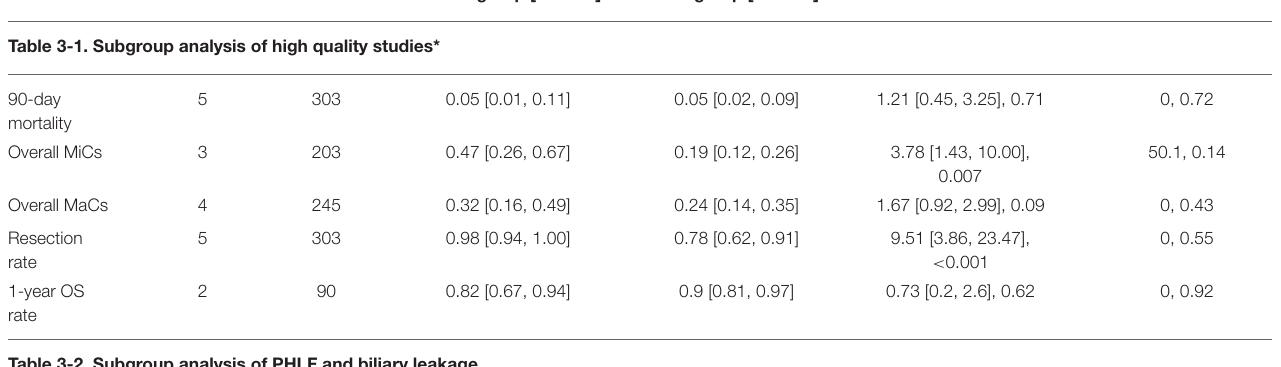
Table 3-2. Subgroup analysis of PHLF and biliary